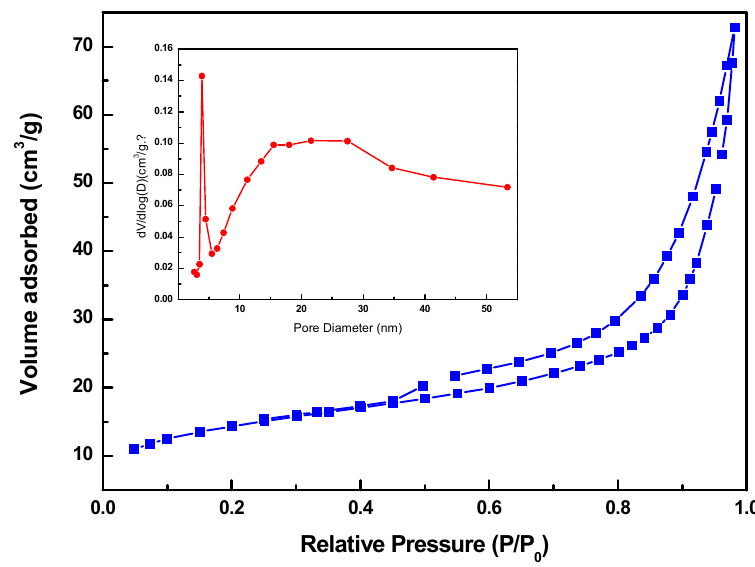
Figure 7. Nitrogen adsorption–desorption isotherm of TiO 2 and its BJH pore size distribution desorption plot (inset image).